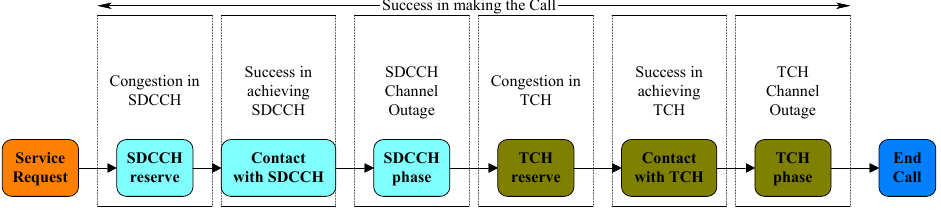
Figure 3. The steps of making a call in the GSM network with the network performance measurement indicators. ment